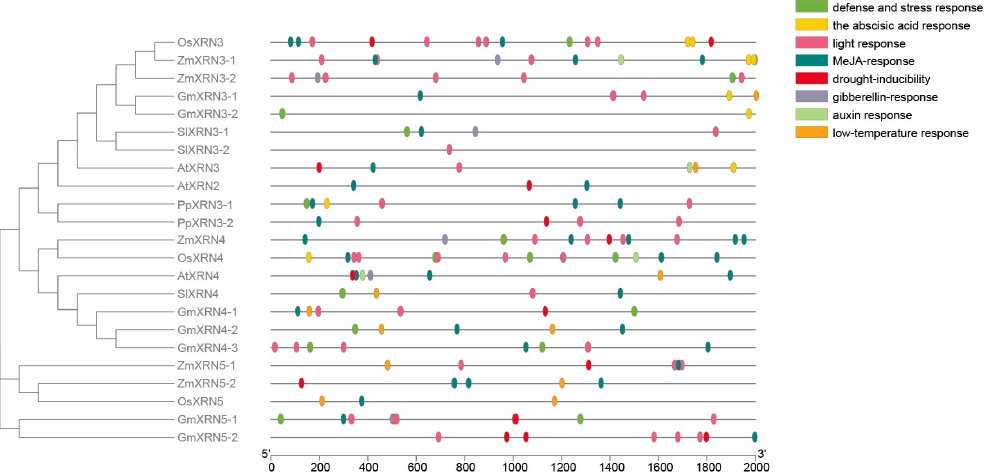
Figure 4. The promoter cis-element analysis of XRN genes in 6 plant species. Differently colored boxes represent the cis elements response to different environmental stresses and plant hormones.